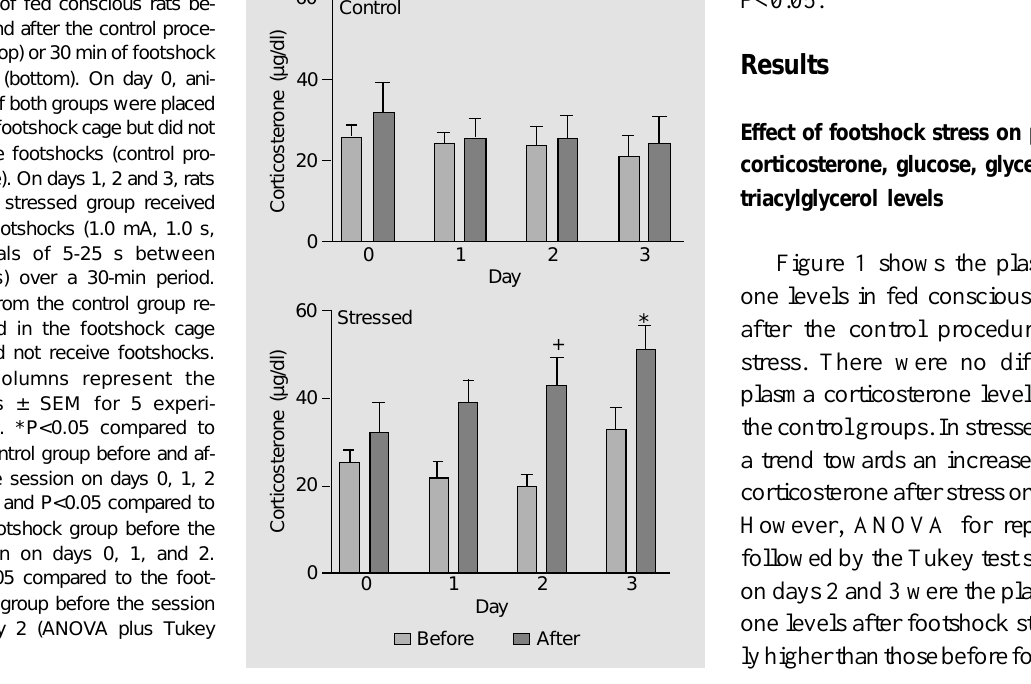
Figure 1. Plasma